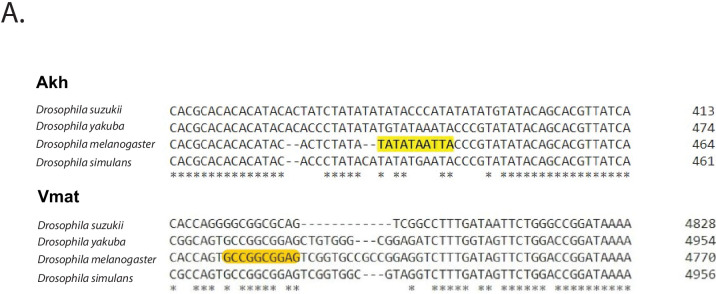
Multiple-sequence alignment was performed for regions around Atx2 binding motifs in Akh and Vmat genes between Drosophila melanogaster and closely related Drosophila species.